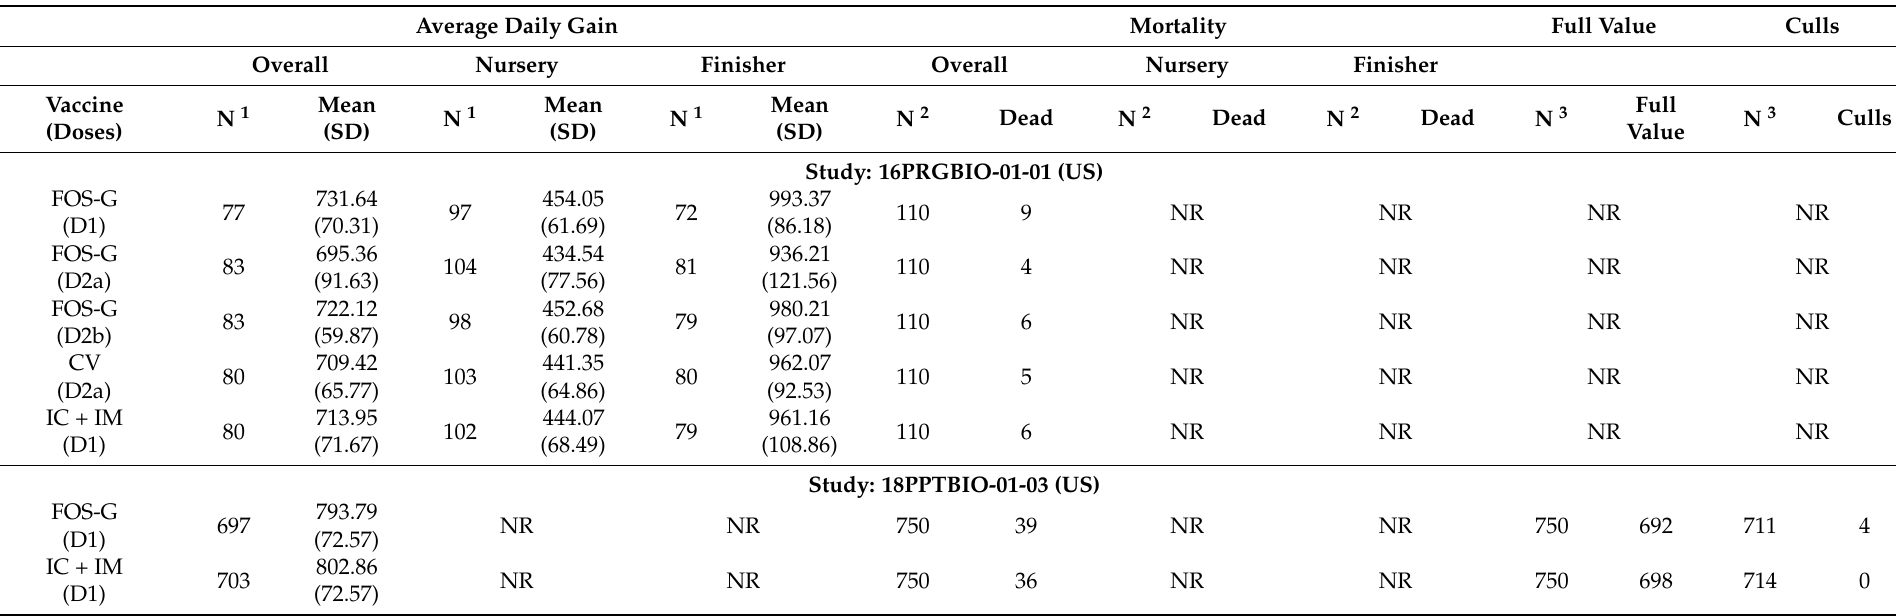
Table 1. Overview of outcome data that were included in meta-analysis and have been derived from hitherto unpublished US field trials, considering an experimental challenge model with porcine circovirus type